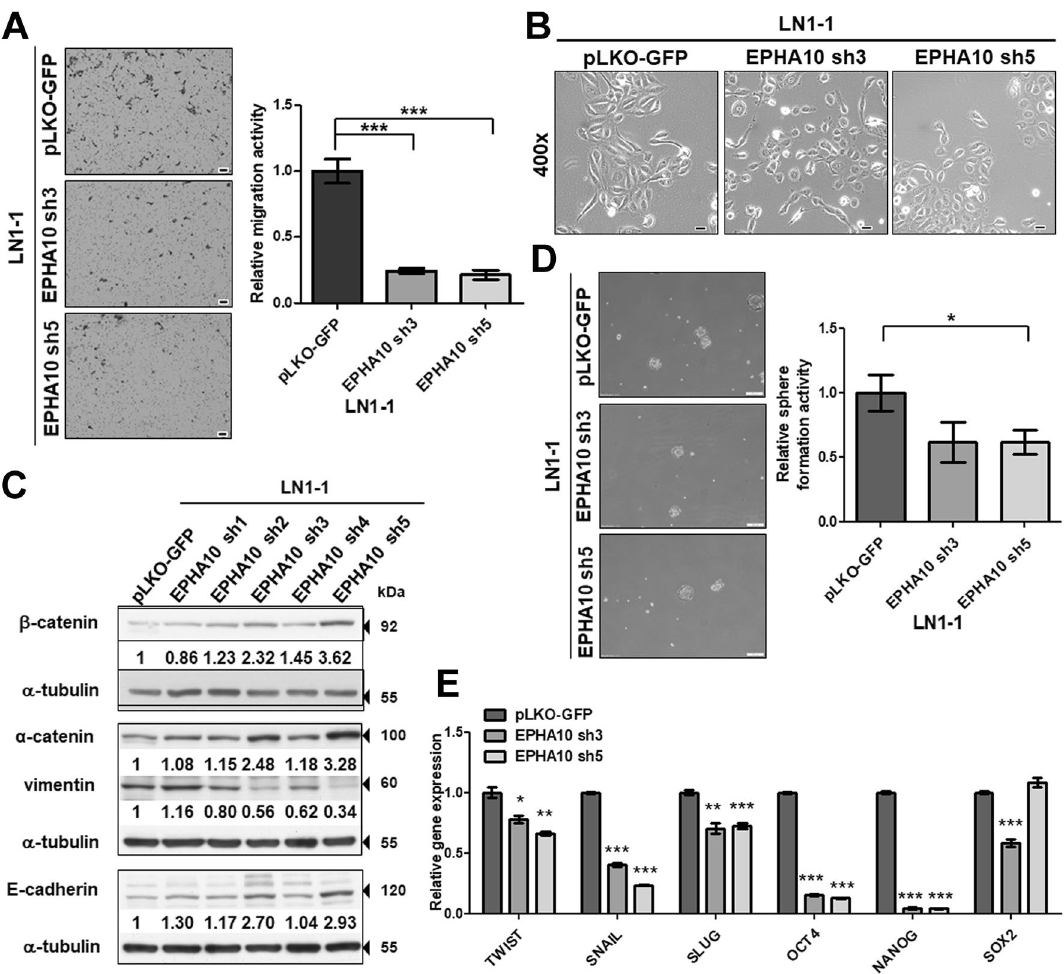
Figure 2. EPHA10 influences cell migration, epithelial–mesenchymal transition, tumorsphere formation and gene expression in LN1-1 cells. ( A ) Left: Representative images of migrated cells. Scale bars, 100 μm. Right: Relative migration activity of the EPHA10 knockdown cells was calculated by normalizing the mean number of migrated cells per field (EPHA10 sh3 and sh5, n = 10) to that of the control cells (pLKO-GFP, n = 10). ( B ) Morphology of LN1-1 pLKO-GFP, EPHA10 sh3, and EPHA10 sh5 cells. Scale bars, 20 μm. ( C ) Immunoblot analysis of α-catenin, β-catenin, vimentin, and E-cadherin proteins in LN1-1 cells with EPHA10 knockdown (EPHA10 sh1–5) and the control vector (pLKO-GFP). Protein levels were normalized to α-tubulin. Relative ratios were determined by dividing the level of the protein of interest in each expression variant by that in the pLKO-GFP vector-expressing cells. ( D ) Left: Representative images of tumorspheres in LN1-1 pLKO- GFP, EPHA10 sh3, and EPHA10 sh5 cells. Scale bars, 100 μm. Right: Relative sphere formation activity was determined by normalizing the mean number of spheres per field for the EPHA10 sh3 and sh5 cells (n = 2) to that of the pLKO-GFP cells (n = 2). (E) The levels of TWIST , SNAIL , SLUG , OCT4 , NANOG , and SOX2 mRNA in LN1-1 pLKO-GFP, EPHA10 sh3, and EPHA10 sh5 cells were determined by qRT-PCR. The amplifications were first normalized to β-actin (internal control). For each gene, the relative expression in LN1-1 EPHA10 sh3 and EPHA10 sh5 cells (n = 3) was normalized to that in the LN1-1 pLKO-GFP cells (n = 3). Bars represent SE; * p < 0.05; ** p < 0.01; *** p < ERK inhibition abolished EFNA4‑induced cellular functions. To further characterize EFNA4- induced forward signaling, we treated OEC-M1 cells with EFNA4-Fc, and the levels of phosphorylated forms of focal adhesion kinase (FAK), protein kinase B (PKB/AKT), and extracellular signal-regulated kinase (ERK), as well as non-phospho-β-catenin and integrin-linked kinase (ILK) were assayed at different time points by western blotting (Figs. S5, 4A). EFNA4-Fc induced activation/phosphorylation of only ERK in OEC-M1 cells (Fig. 4A). The blockage of ERK activation by PD98059, an inhibitor of mitogen-activated protein kinase (MAPK) kinase, inhibited EFNA4-induced cell migration (Fig. 4B), spheroid formation (Fig. 4C), and expression of SNAIL , OCT4 , and NANOG mRNA (Fig. 4D). Confirmation of the effects of PD98059 on EFNA4-induced NANOG expression is shown in Fig. 4E. Our results indicated that exogenous EFNA4-induced functional changes were dependent on MAPK/ERK activation. To verify the role of NANOG in EFNA4-induced migration and sphere formation, NANOG expression in OEC-M1 cells was abolished using lentiviral shRNA and confirmed by qRT-